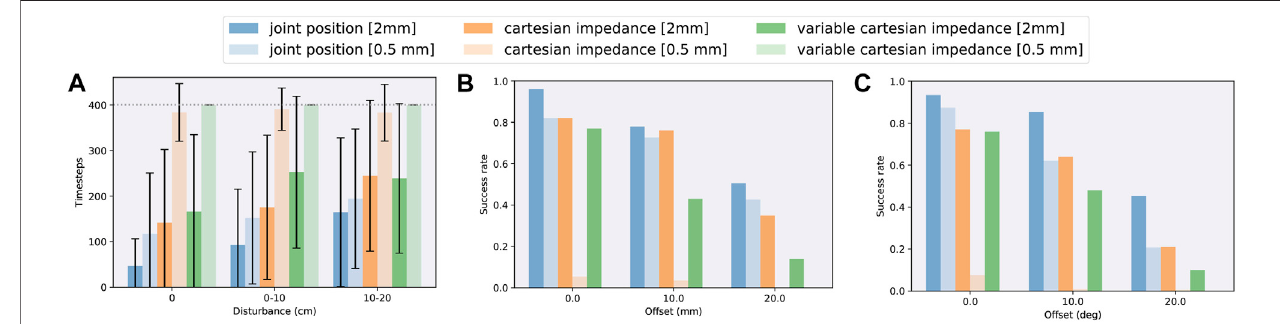
FIGURE 4| Robustness when using different action spaces (joint position control, Cartesian impedance control, and variable Cartesian impedance control) on the task of dual-arm peg-in-hole assembly in simulation separated for different clearances. (A) Average episode durations when applying a random disturbance to the peg during a fi xed time frame in the beginning of each episode. (B) Average success rates when applying a random position offset to the peg. (C) Average success rates when applying a random orientation offset to the peg.